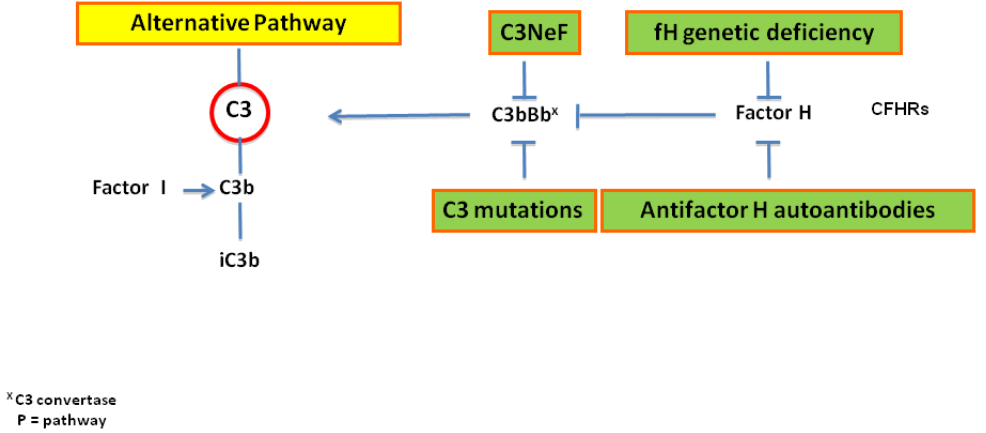
Figure 3. Schematic dysregulation of the C3 activation in C3 GP.